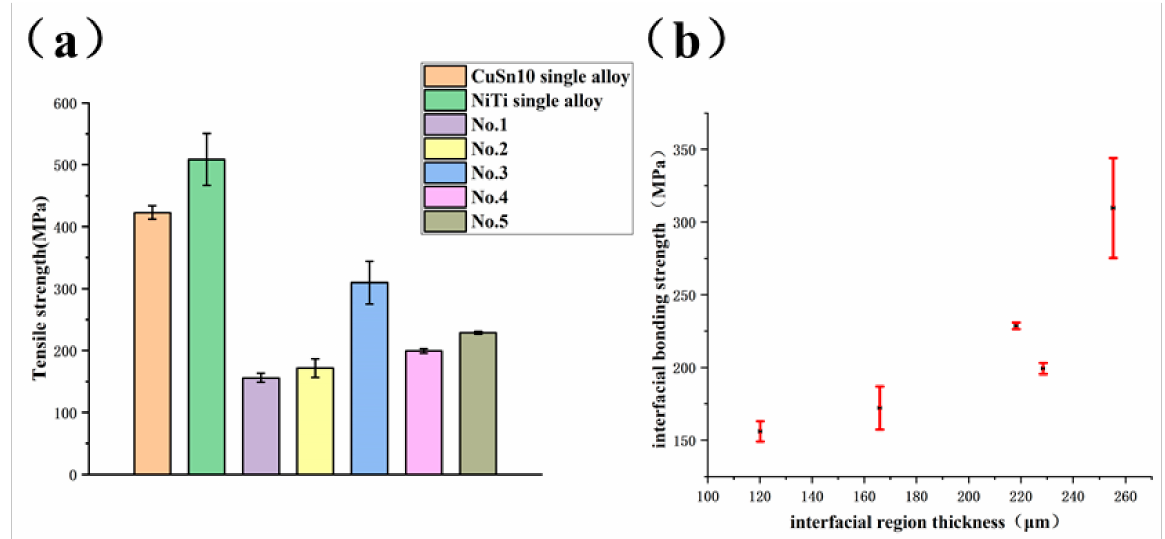
Figure 9. ( a ) The interfacial bonding strengths of different samples compared with the tensile strength of CuSn10 and NiTi single alloy ( b ) relationship between interfacial bonding strength and interfacial region